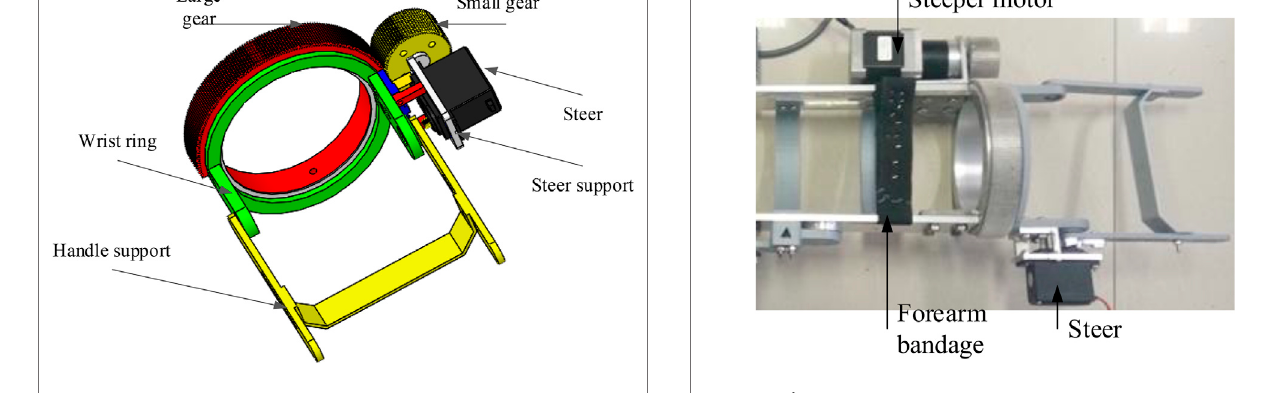
FIGURE 5 | 3D drawing of hand support structure. FIGURE 6 | Physical model of the exoskeleton